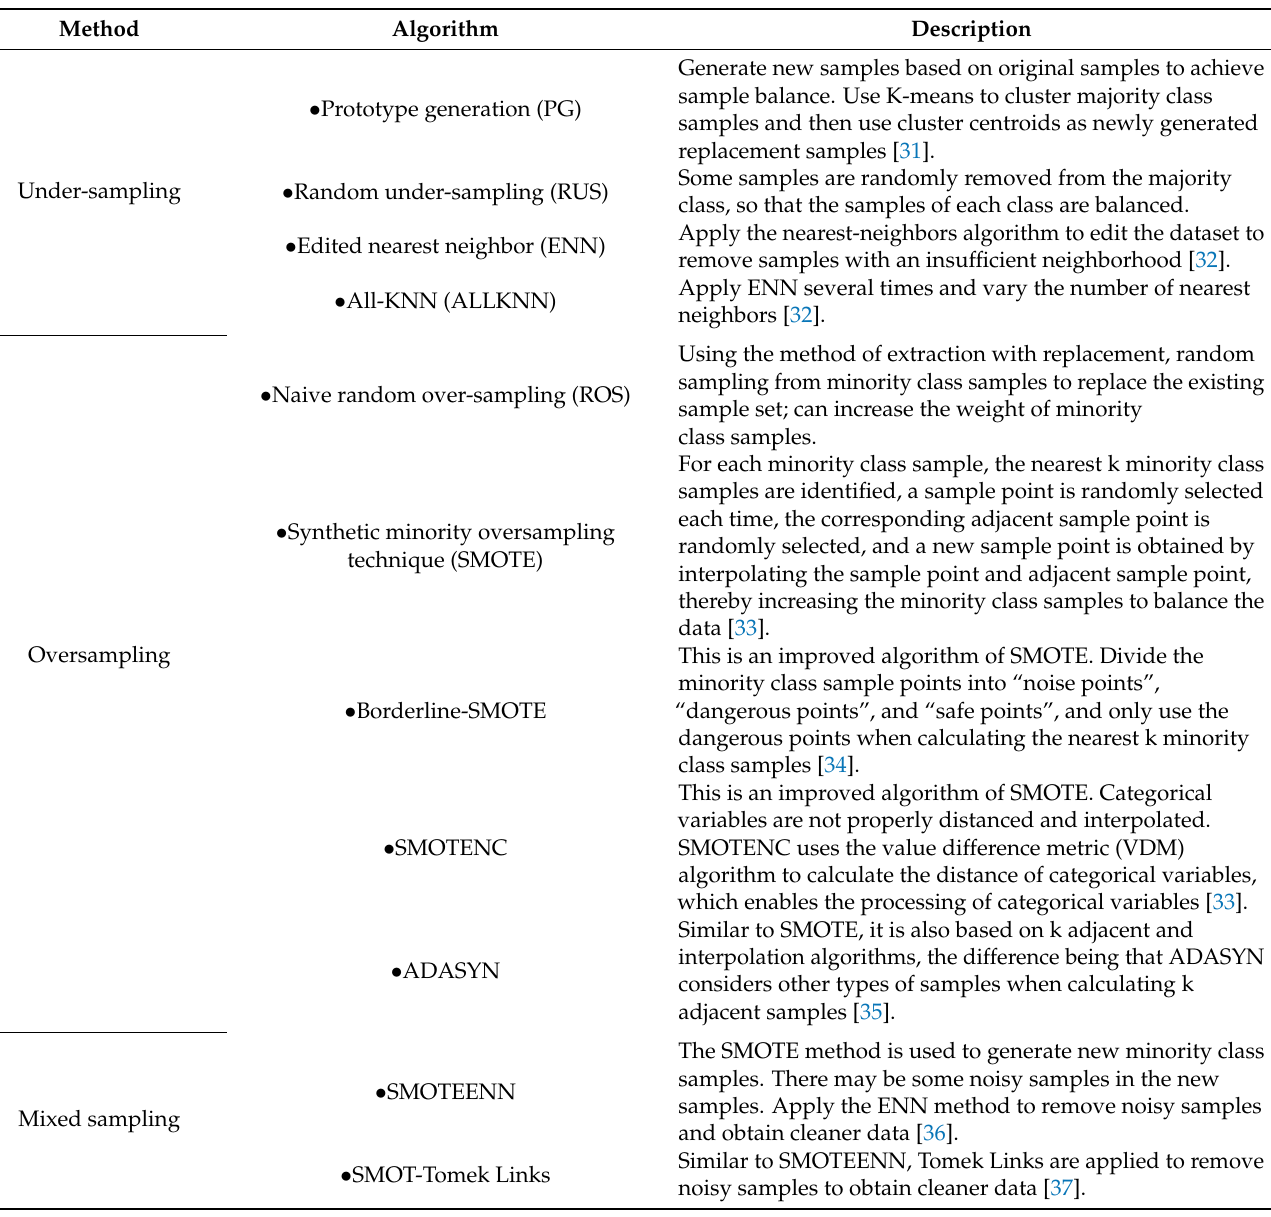
Table 3. Overview of the 11 resampling algorithms used in this